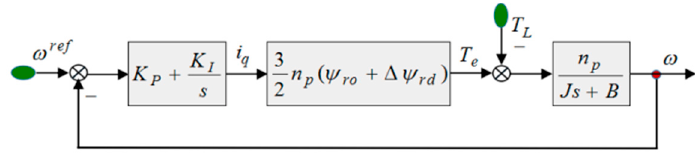
Figure 1. Block diagram of PMSM speed loop control.